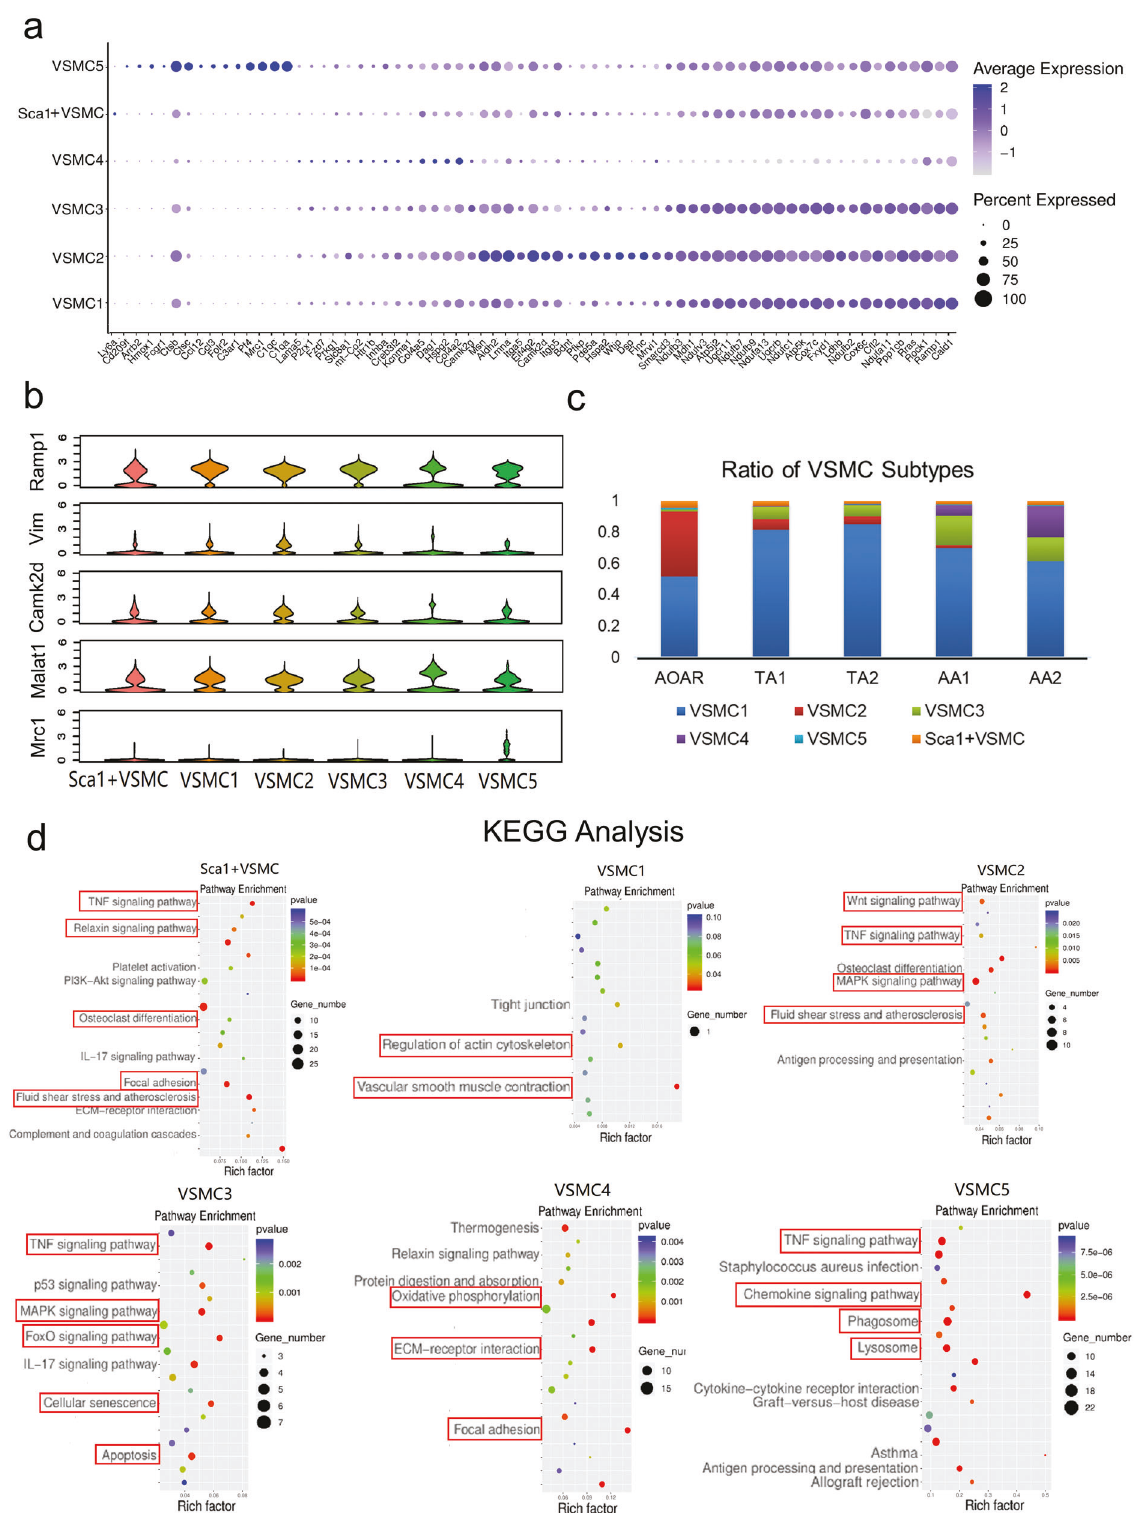
Fig. 3 System of vascular smooth muscle cell (VSMC) subtypes performing their own functions. a Vascular smooth muscle cells could be subdivided into six subpopulations marked with different genes shown by the dot plot. The VSMC subtypes featured a series of correlative marker genes involving a similar expression. b For each subtype, one representative gene was chosen as a potential detection target as follows: Ramp1 for VSMC 1, Vim for VSMC 2, Camk2d for VSMC 3, Malat1 for VSMC 4, Mrc1 for VSMC 5. c The proportion of each VSMC subtype in all smooth muscle cells across different segments is displayed by bar graphs. VSMC 2 showed a declining trend, whereas VSMC 3 and 4 presented with an increasing trend, consistent with the phenomenon across all cell types. d KEGG analysis con fi rmed the characteristic enriched pathways of the six VSMC subtypes